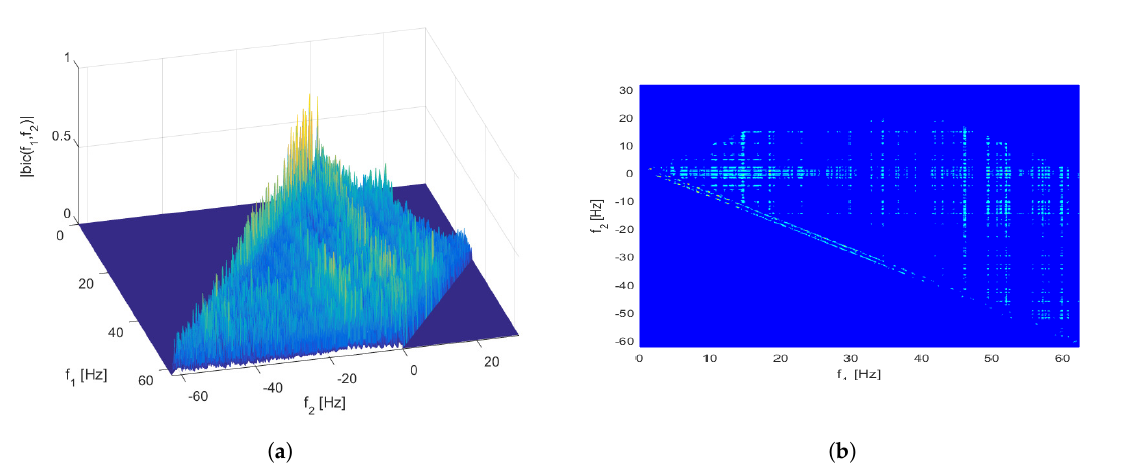
Figure 3. Mesh ( a ) and contour ( b ) plots of the cross bicoherence between PPG1 signal and z -axis acceleration data for dataset